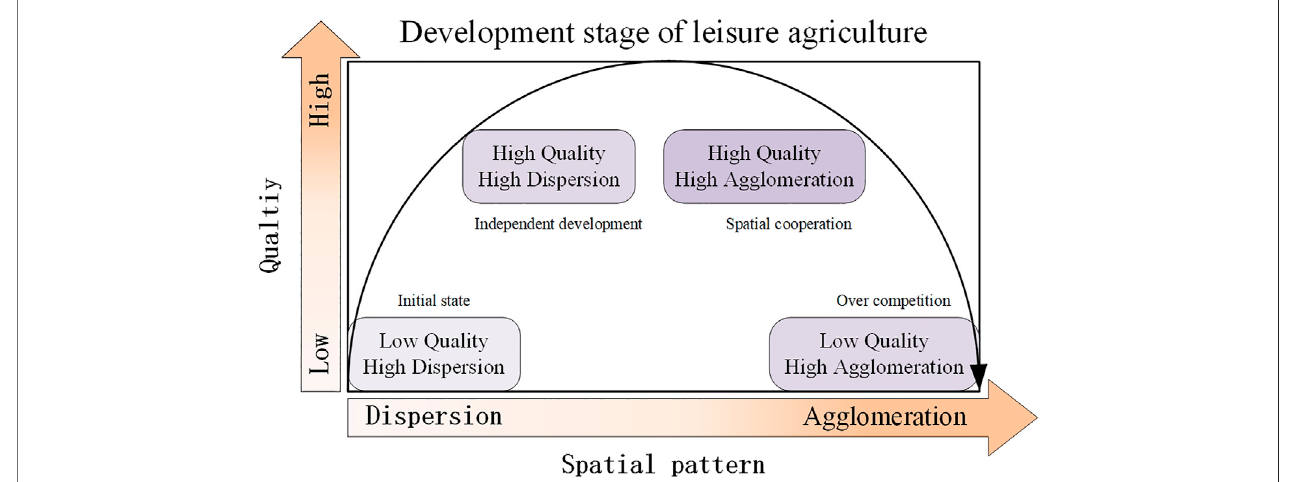
FIGURE 1 | Theoretical